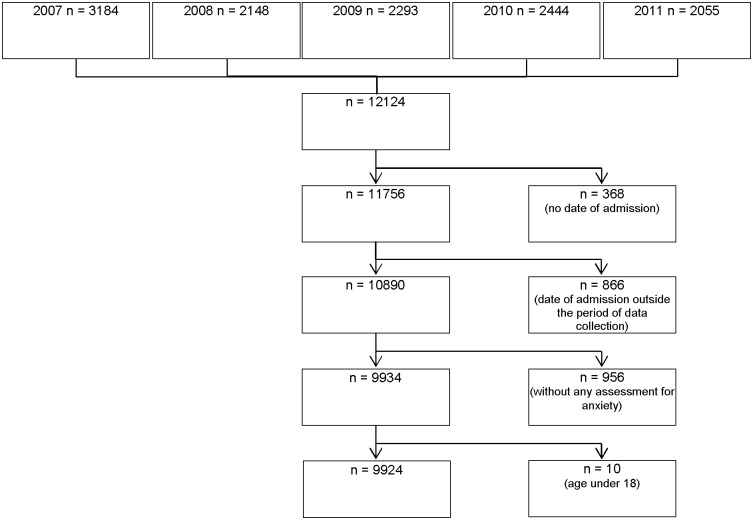
Flow of study participants.